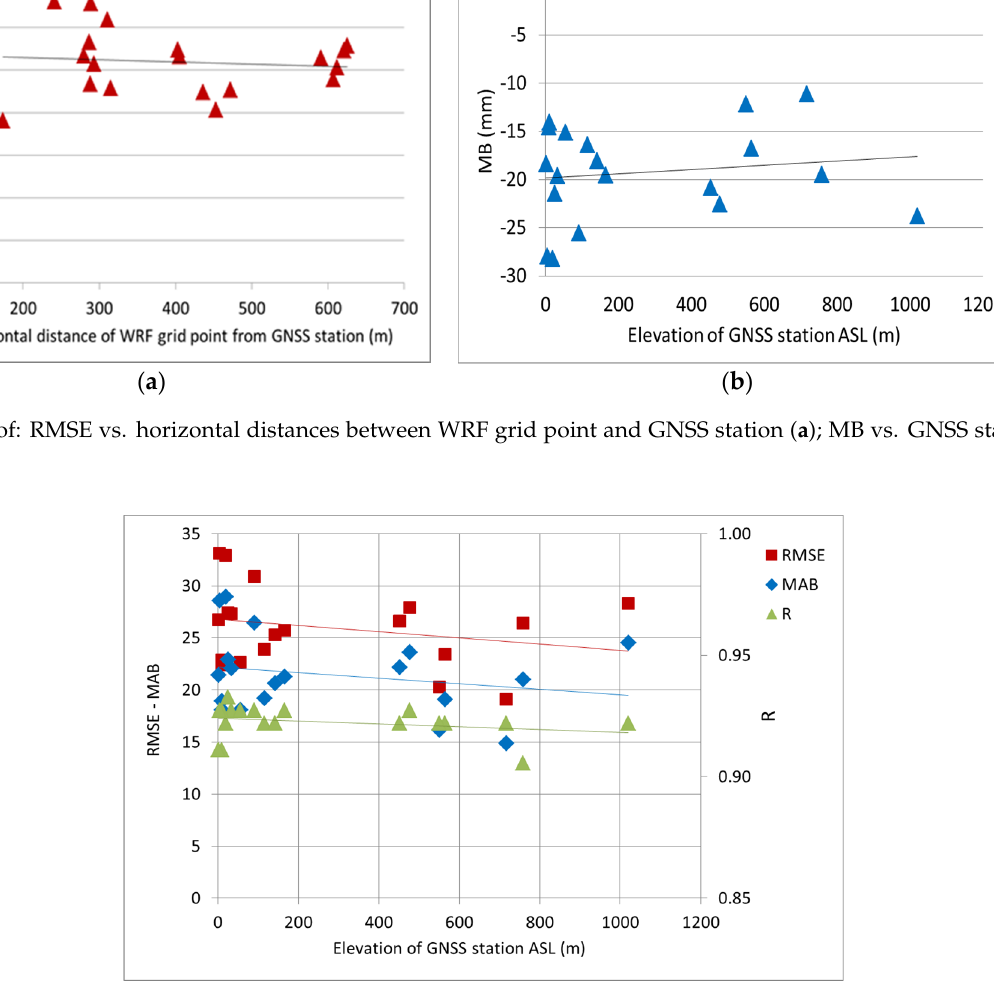
Figure 10. Distribution of model validation metrics (MAB, RMSE and R) per station elevation h.